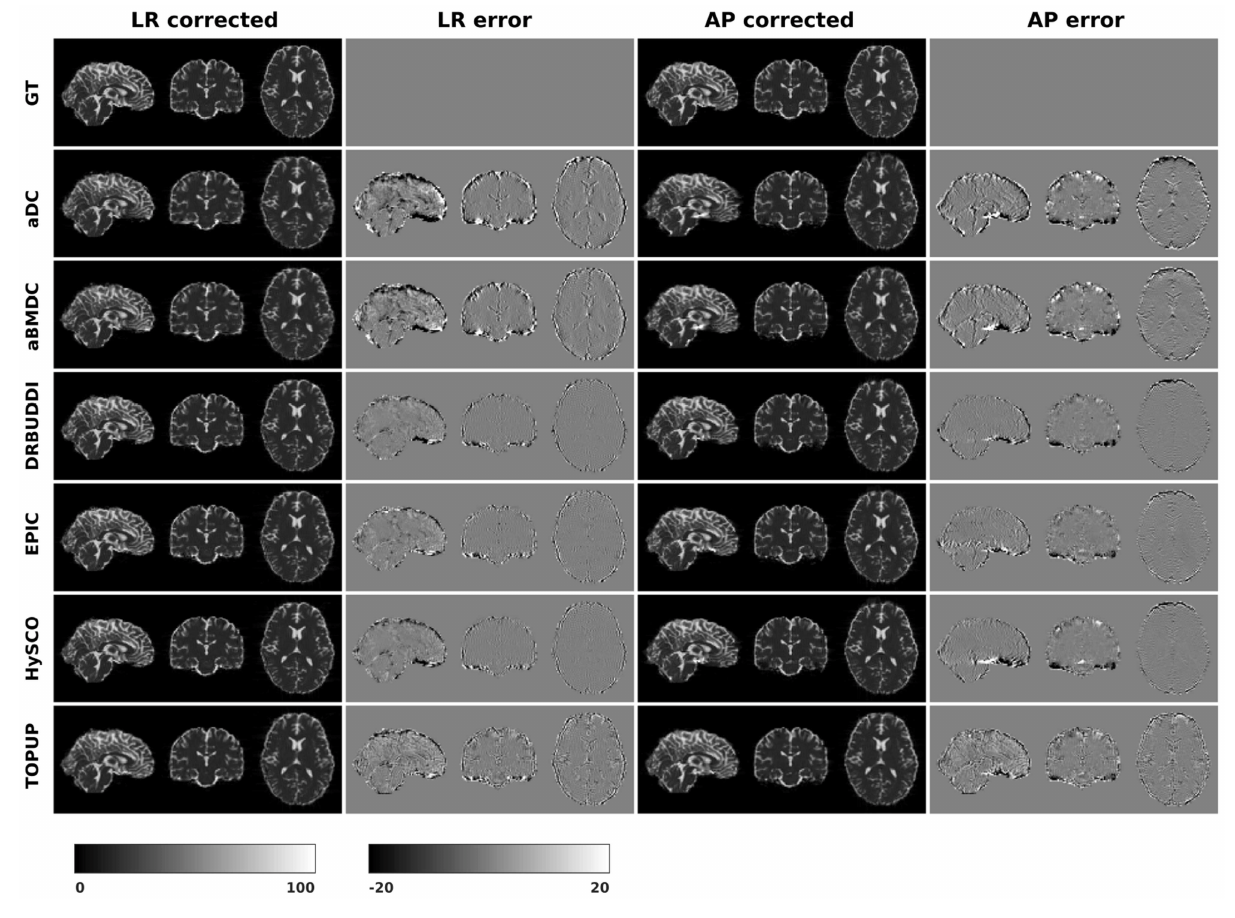
Frontiers in Neuroinformatics |